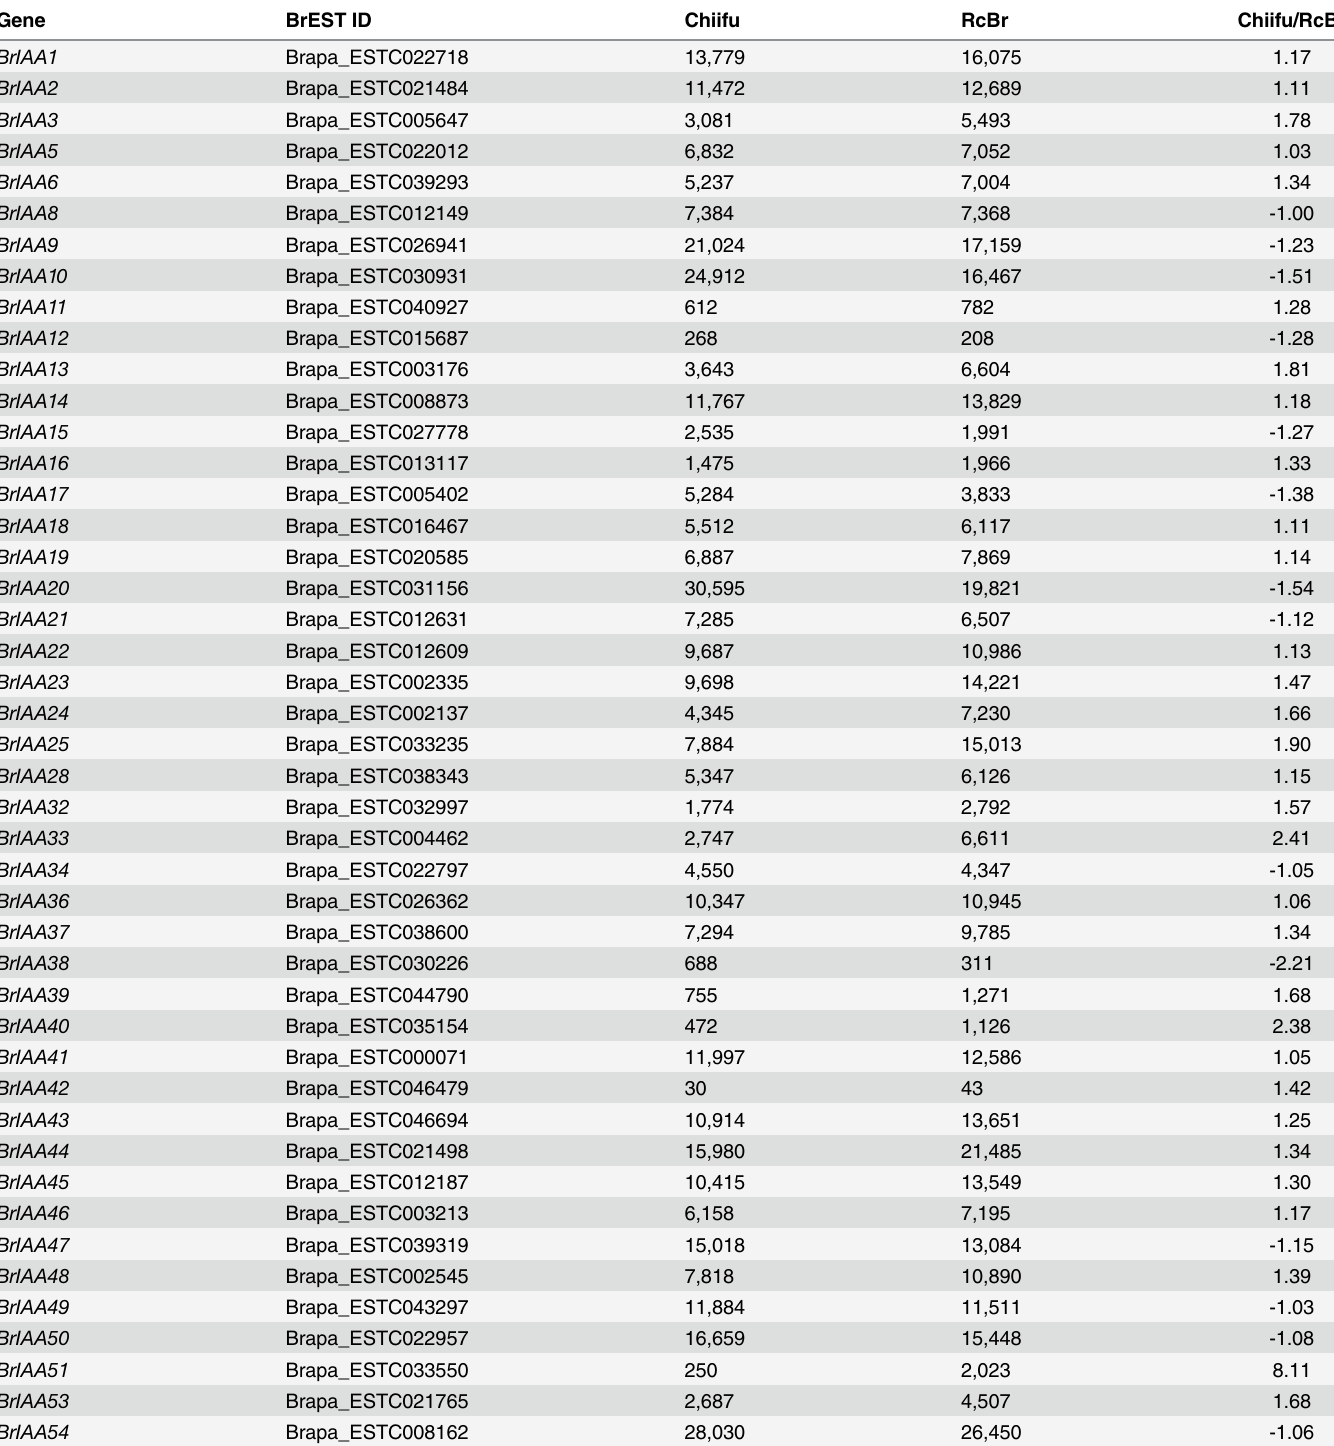
Table 2. Expression ratio of BrIAA genes in Chiifu and RcBr inbred lines.